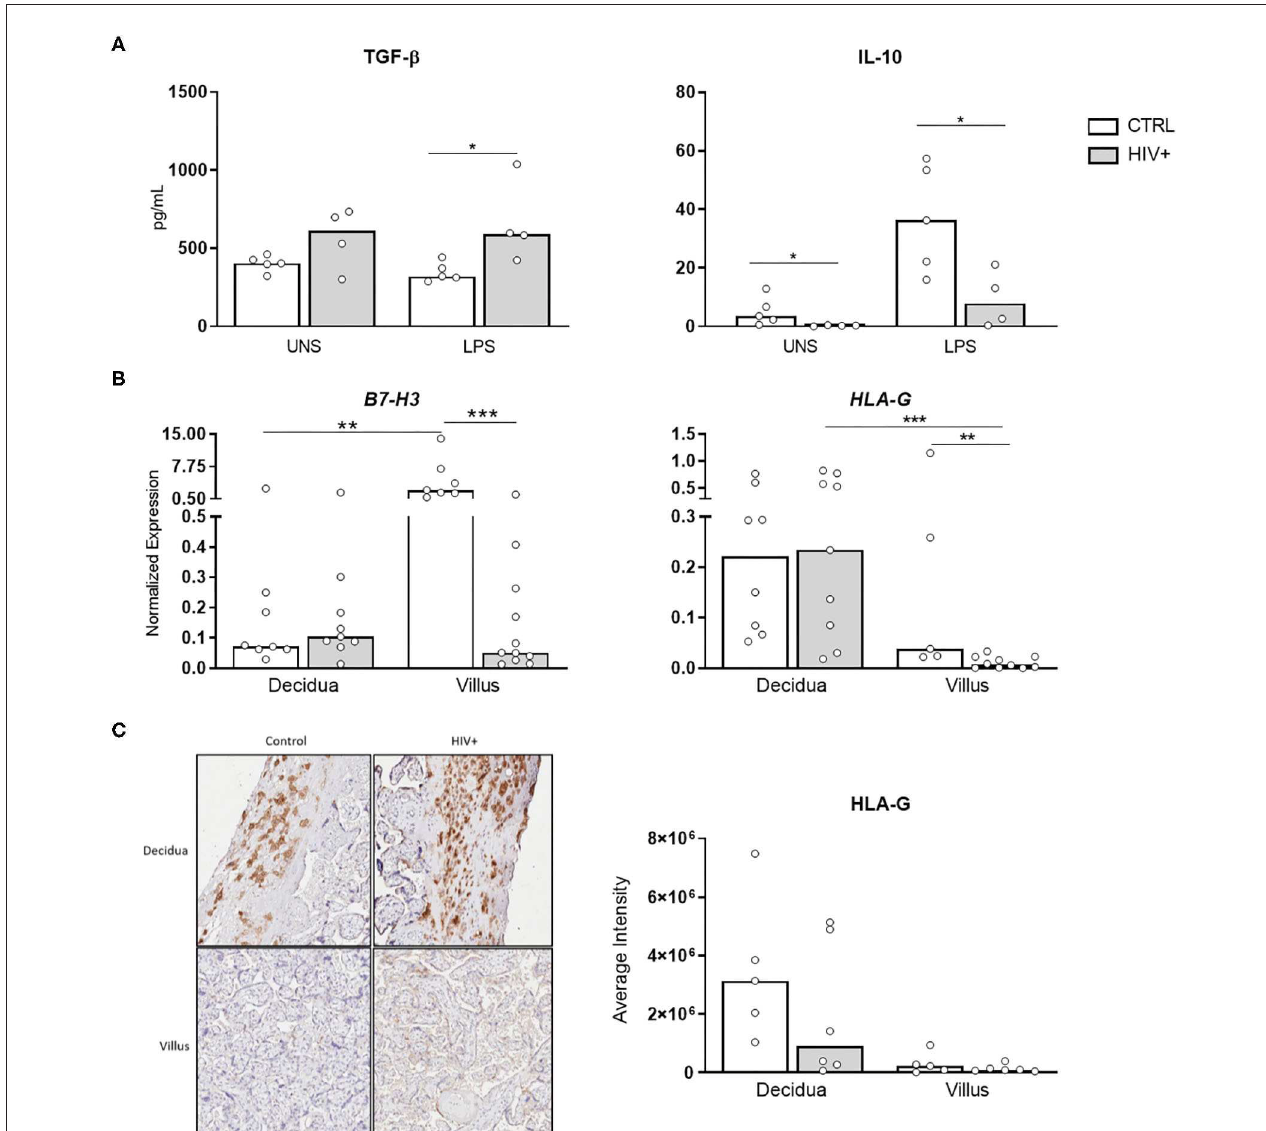
FIGURE 5 | Decrease of tolerogenic factors in placental tissue from HIV-infected mothers. (A) Secretion levels of TGF- β and IL-10 in supernatant from placental explants from HIV-infected (gray bar, n = 4) and control uninfected mothers (white bar, n = 5) stimulated with TL4 agonist was evaluated by cytometric bead array. UNS, unstimulated. The detection limits were: IL-10, 0.13 pg/mL; TGF- β , 14.9 pg/mL. (B) mRNA expression levels of B7-H3 and HLA-G in decidua and placental chorionic villi from HIV-infected (gray bar, n = 9–11) and control uninfected mothers (white bar, n = 5–8) was evaluated by RT qPCR. (C) HLA-G protein levels were analyzed by immunohistochemistry in decidua and placental chorionic villi from HIV-infected (gray bar, n = 6) and uninfected mothers (white bar, n = 5). Expression values are represented as median. Mann-Whitney U or Wilcoxon signed-rank test: * p < 0.05, ** p < 0.01, *** p < 0.001.